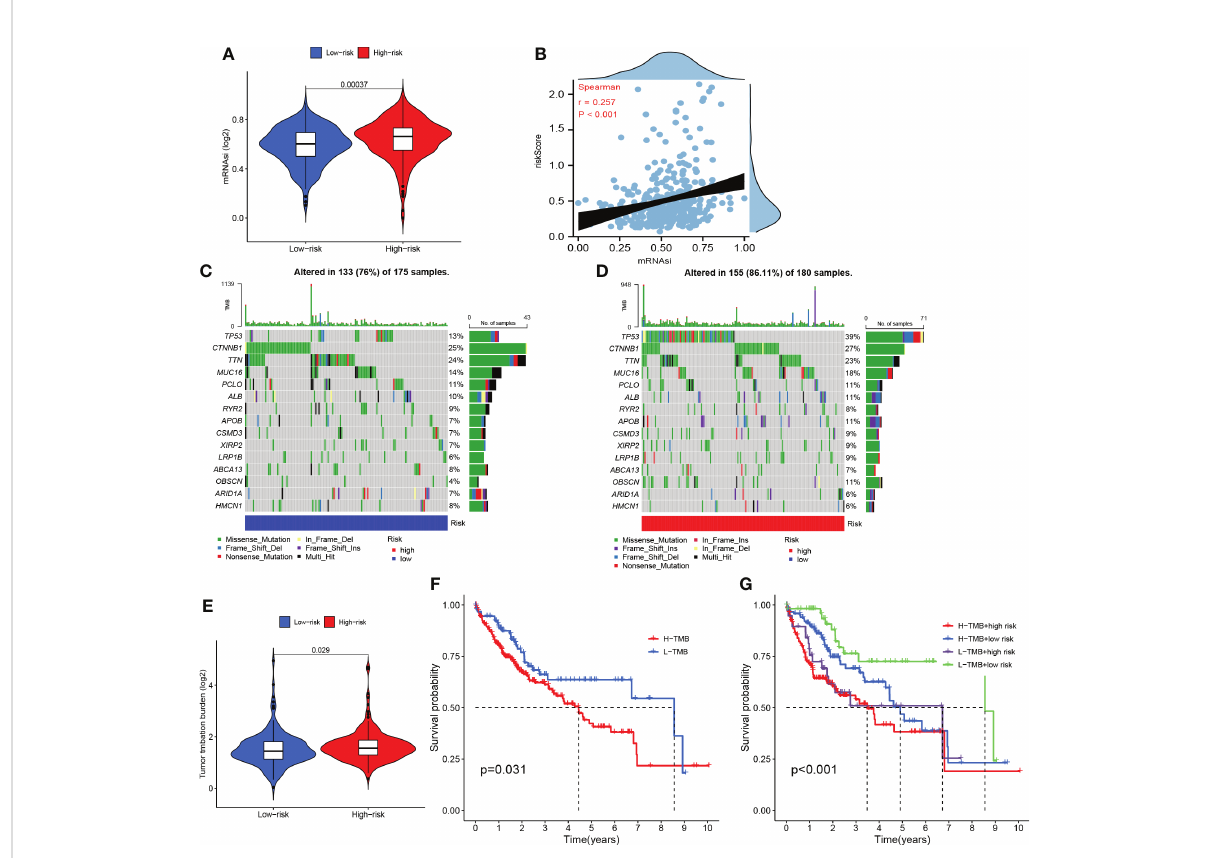
FIGURE 11 Somatic mutation and stemness analysis. (A) Comparison of mRNAsi in high- and low-risk groups. (B) The correlation between the risk score and mRNAsi. (C) The top 20 mutated genes in the high-risk group. (D) The top 20 mutated genes in the low-risk group. (E) Comparison of tumor mutation burden (TMB) in high- and low-risk groups. (F) KM curve of TMB. (G) KM curve of TMB +